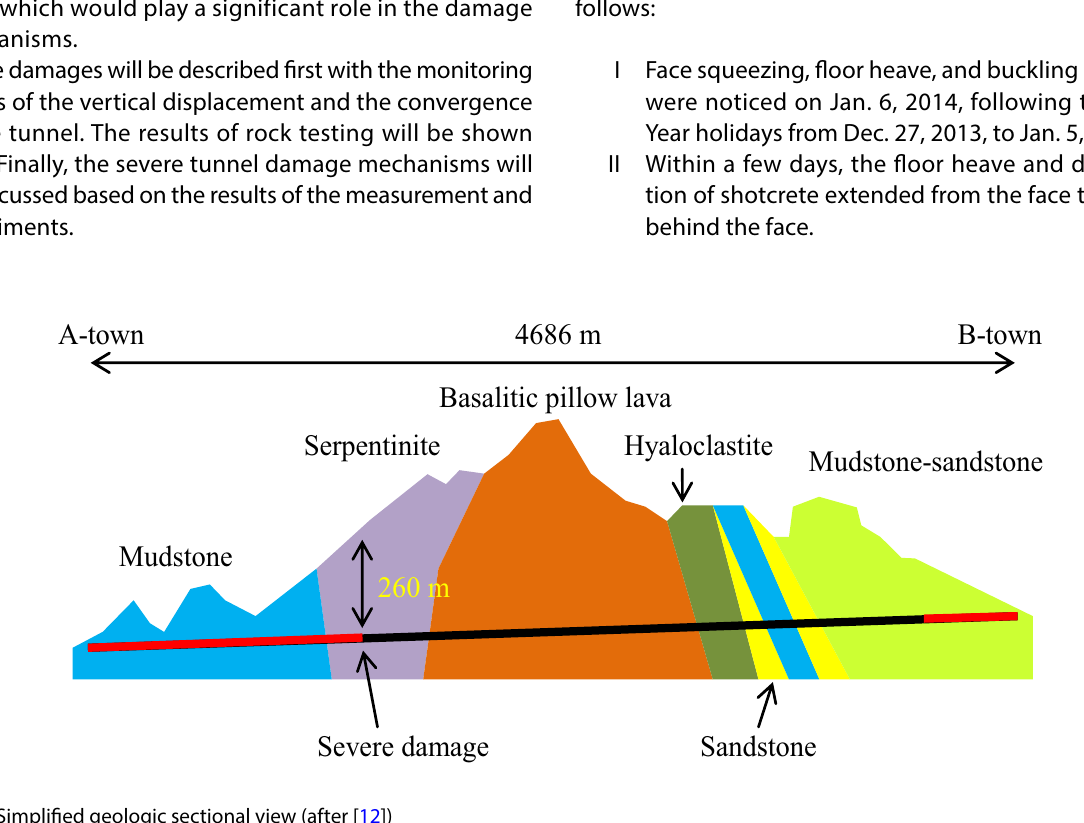
Fig. 1 Simplified geologic sectional view (after